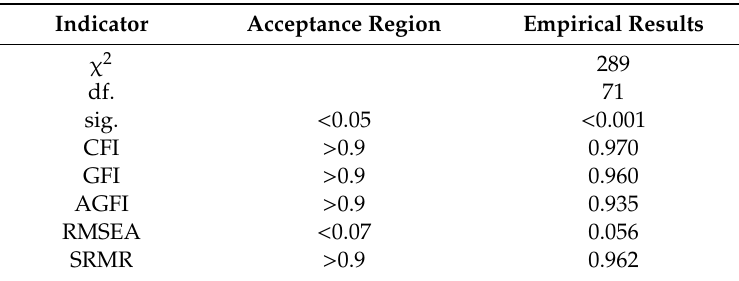
Table 10. The reliability of the measuring tools applied.